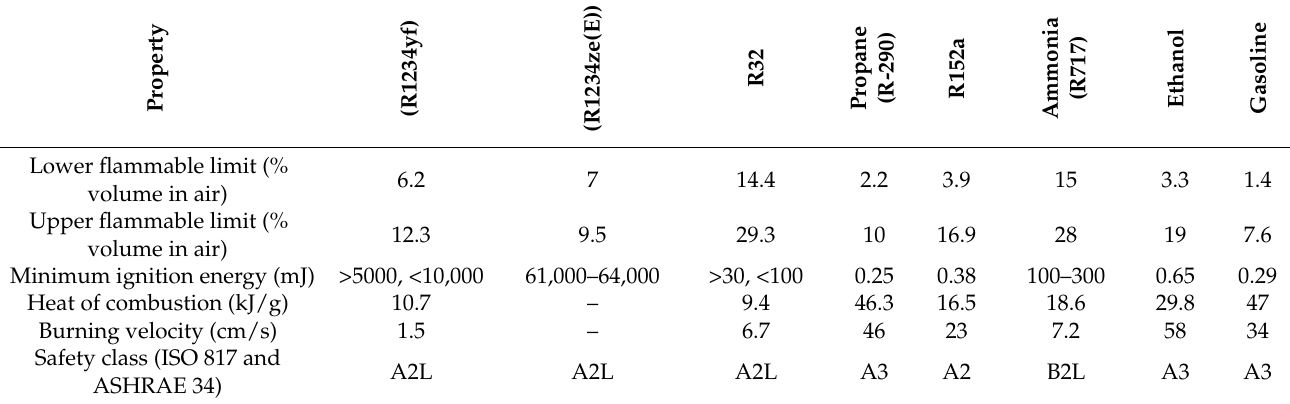
Table 4. Flammability characteristics of some pure low-GWP refrigerants